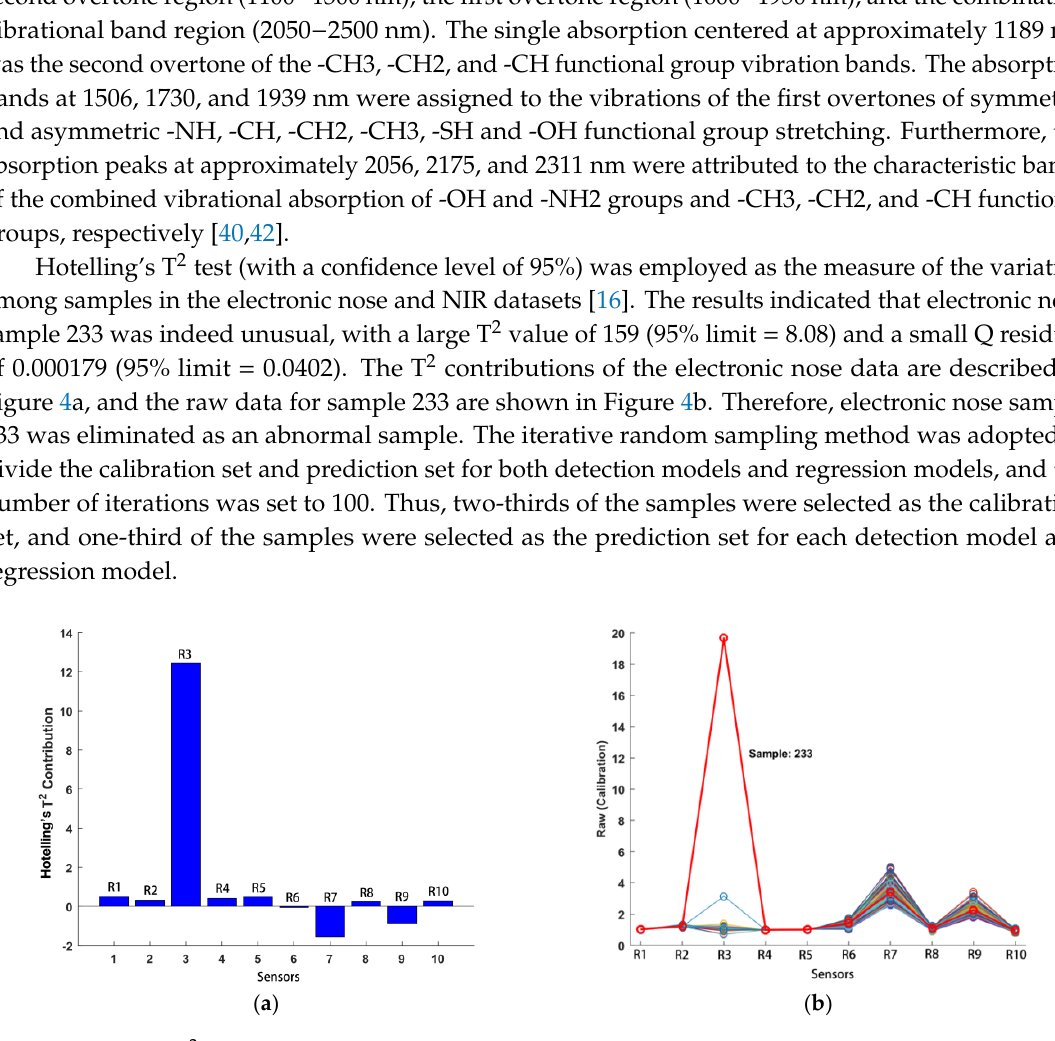
Figure 4. The T 2 contributions of ( a ) each electronic nose sensor and ( b ) the electronic nose raw data for sample 233.